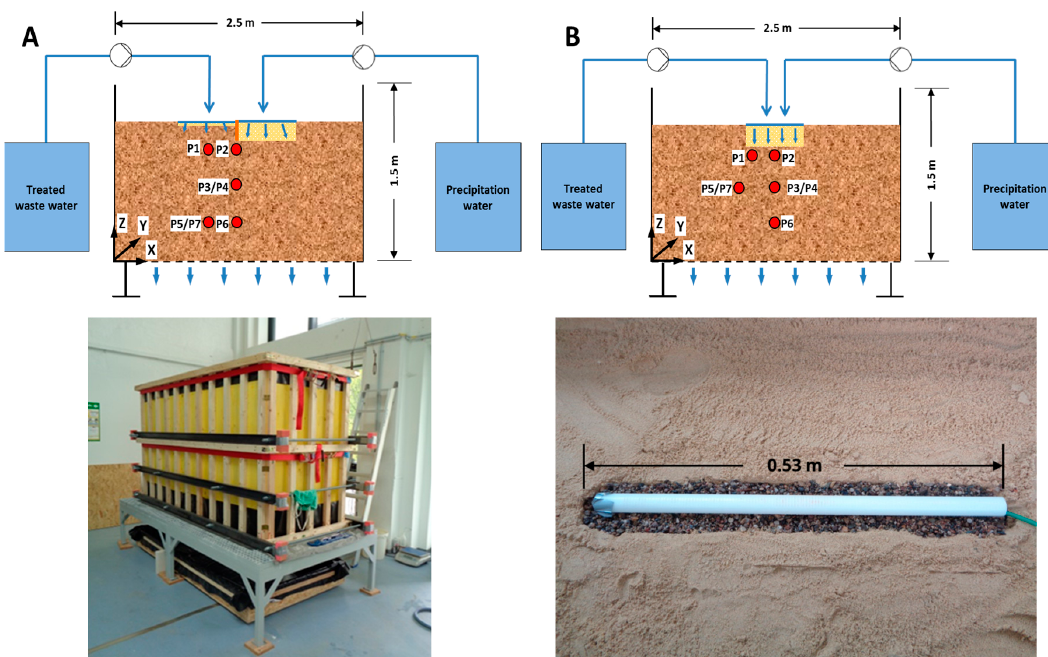
Figure 1. Set-up of three-dimensional (3D)-Tank with separated, closely-spaced ( A ) as well as joint infiltration ( B ) of treated waste water and precipitation with positions of observation points as listed in Table 2 (please note that observation points P4 and P7 are out-centered from points P3 and P5, respectively), left photo shows the tank, right photo shows realization of the treated waste water ditch using a slotted plastic pipe.